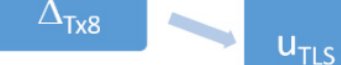
Figure 12. Two point clouds originating from measurements using terrestrial laser scanning (TLS) and unmanned aerial vehicle (UAV) methods.